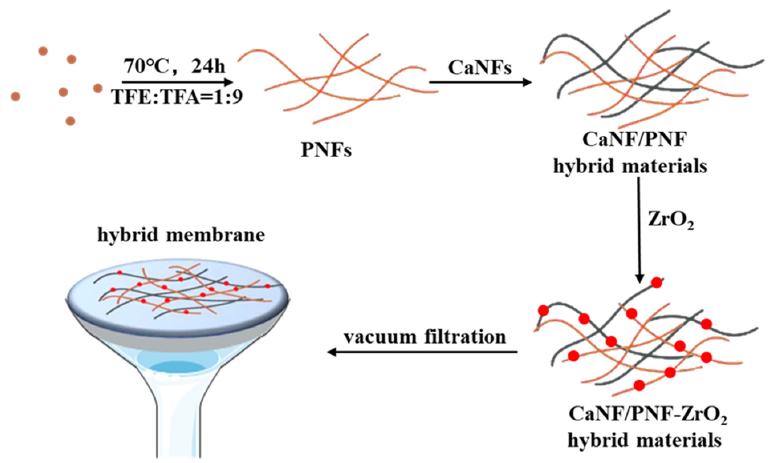
Figure 2. Schematic presentation of biomimetic synthesis of CaNF/PNF-ZrO 2 hybrid materials and fabrication of hybrid nanofiber membrane by vacuum filtration.